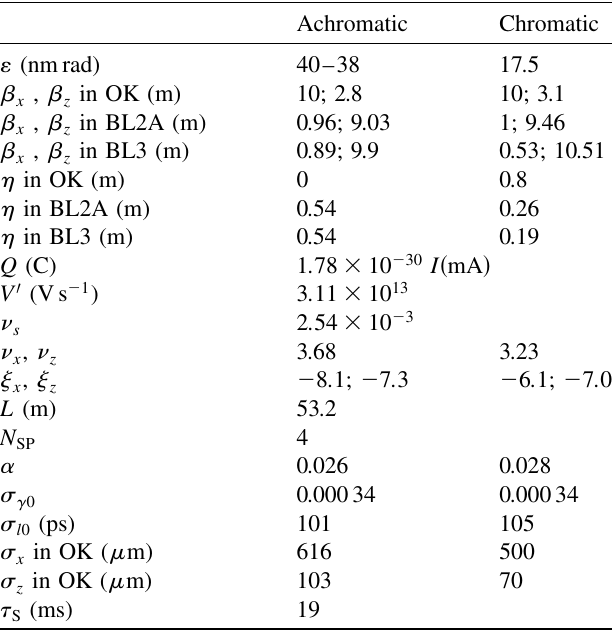
TABLE I. UVSOR-II machine operating point for FEL opera- tion at 600 MeV, for the dispersion and dispersion free. (cid:4) (cid:4) are the betatron functions, Q the charge in the ring, V 0 the z time derivative of the cavity voltage, (cid:5) (cid:5) the betatron tunes, (cid:6) z circumference of the ring, N the momentum compaction factor, (cid:2) (cid:2) the natural energy spread at quasizero current, and (cid:8) (cid:3) 0 synchrotron damping time. For transverse sizes